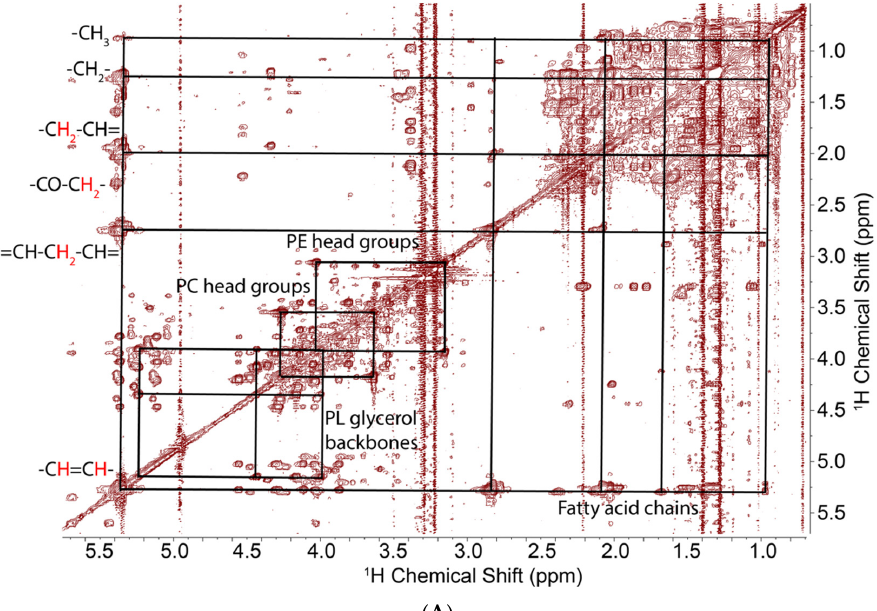
Figure 1. 1D NMR spectra of lipids extracted from UMUC3 WT (wild type) cells. Lipids were extracted from cells grown in the presence of [U- 13 C]-glucose, dried, and redissolved in d 4 -methanol. NMR spectra were recorded at 15 ◦ C with 1D 1 H-NMR collected with 512 transients and an acquisition time of 2 s with 14,368 points using a spectral width of 12 ppm with a relaxation delay of 4.0 s. The data were linear predicted and zero filled to 65,536 data points and well resolved peaks are labeled as shown according to the literature [43] and our in-house standard database. 1 H PRESAT spectrum. ( A ) Upfield region showing acyl chains and cholesterol resonances. The vertical scale is expanded to show the peaks that are small compared with that of the bulk CH 2 resonance at 1.32 ppm. ( B ) Lower: downfield region showing glycerol and headgroup region; inset shows the double bond and glycerol C2 region. Assignments are displayed in the figure. The sharp resonances (asterisks) at 1.4 and 2.2 ppm are from BHT.